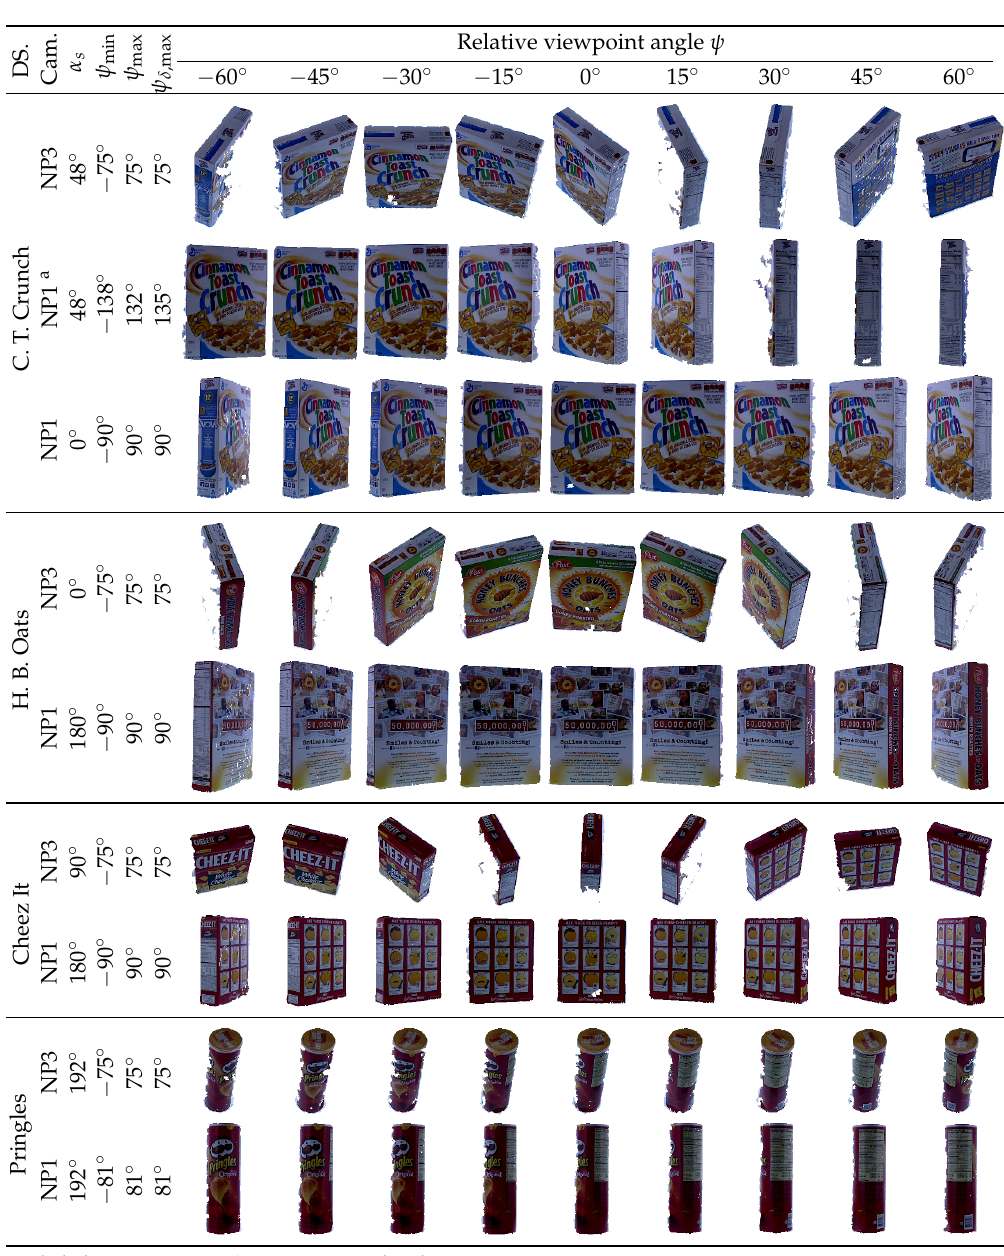
Figure 8. RGB images of the evaluation datasets (DS.) from different cameras (Cam.) sampled along different relative viewpoint angles, ψ . The source image is fixed to α s (equivalent to ψ = 0 ◦ ), while the destination image is taken from the interval [ ψ min , ψ max ] at every 3 ◦ step. Based on the source frame and camera elevation, each dataset limits the viewpoint invariance score, ψ δ , to a specific maximum, ψ δ ,max . Only sample images are